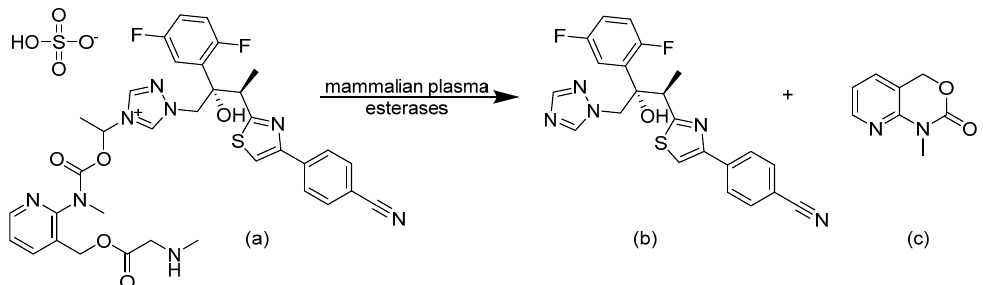
Figure 12. Hydrolysis reaction of the prodrug ( a ) isavuconazonium by mammalian plasma esterases to yield, ( b ) isavuconazole, and ( c ) by-product.